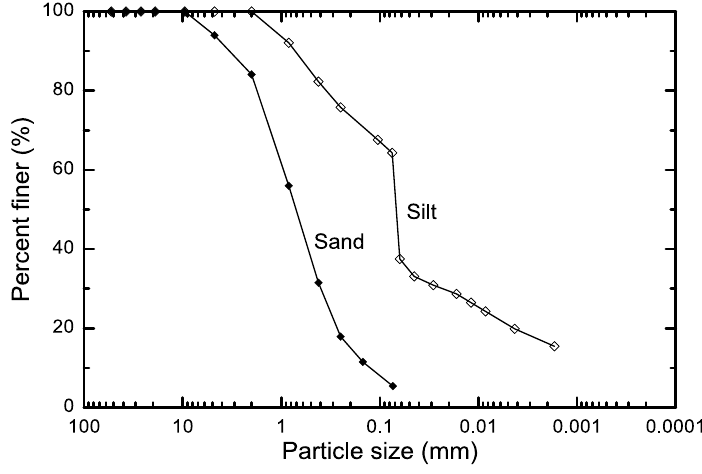
Figure 1. Particle size distributions of sand and silt used in the study.